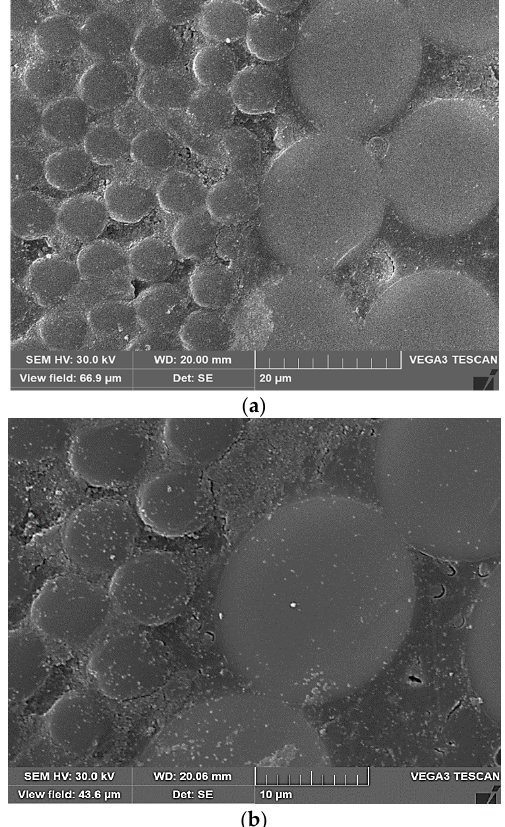
Figure 13. Scanning electron microscopy (SEM) images of HFRP bar specimens: ( a) Micro-defects in FT Samples; ( b ) Micro-cracks in FT-L samples.